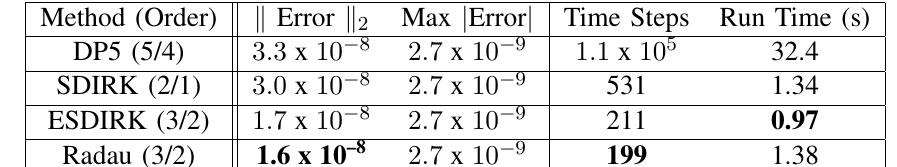
TABLE IV: Accuracy and simulation run-time metrics of the DP5 and IRK methods when solving the AMPAR model. Boldface font denotes best results of each column.